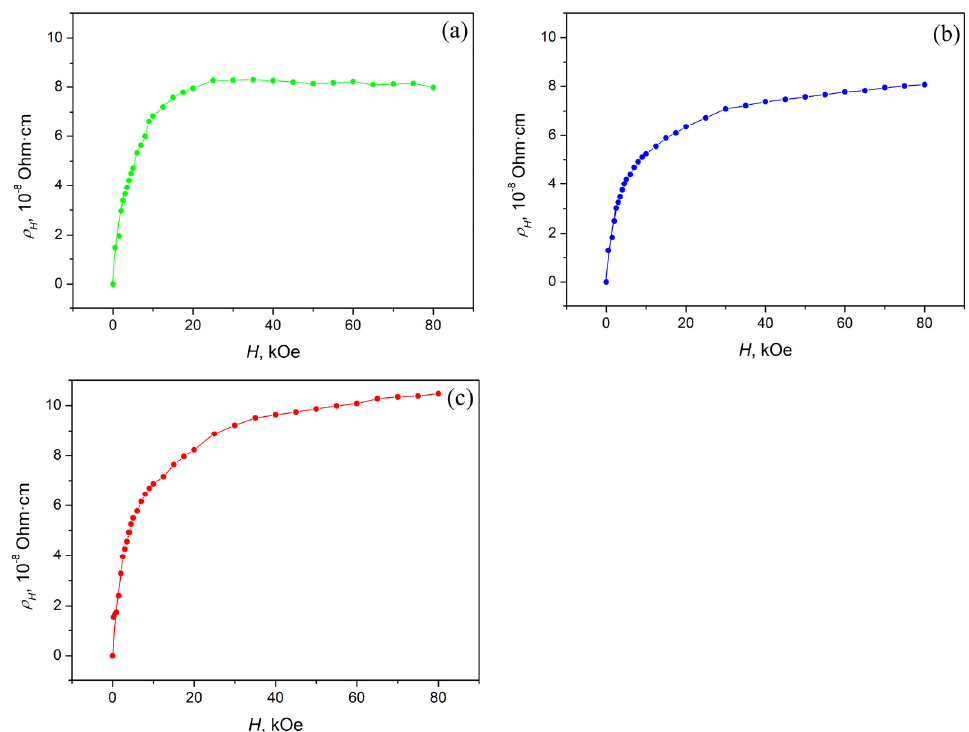
Figure 5. Field dependences of the Hall resistivity ρ H ( H ) at T = 4.2 K: ( a ) Ni 45 Mn 43 In 12 , ( b ) Ni 46 Mn 42 In 12 , ( c ) Ni 47 Mn 41 In 12 .